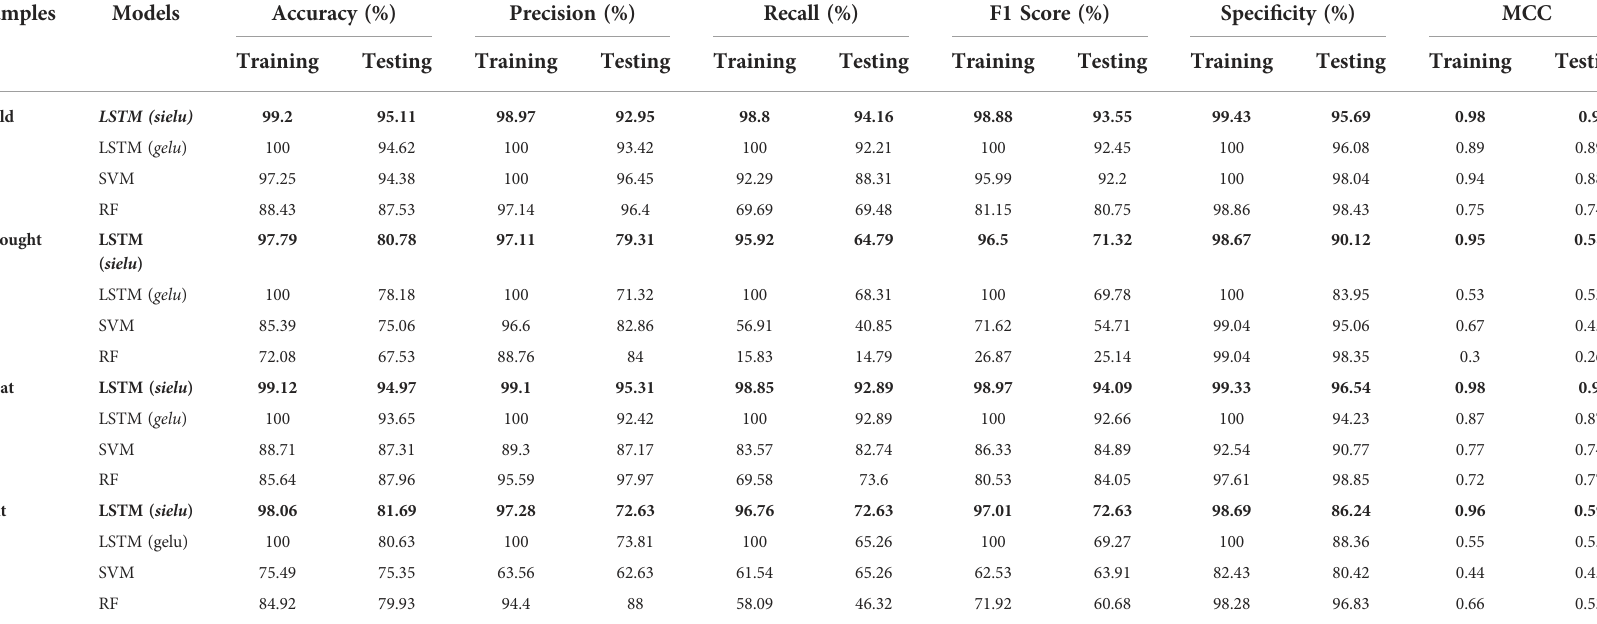
TABLE 2 Comparison of LSTM with sielu and gelu , SVM, and RF for different abiotic stress-associated protein sequences. The fi gures in bold denote the evaluation parameters of the best fi t model for given stress.